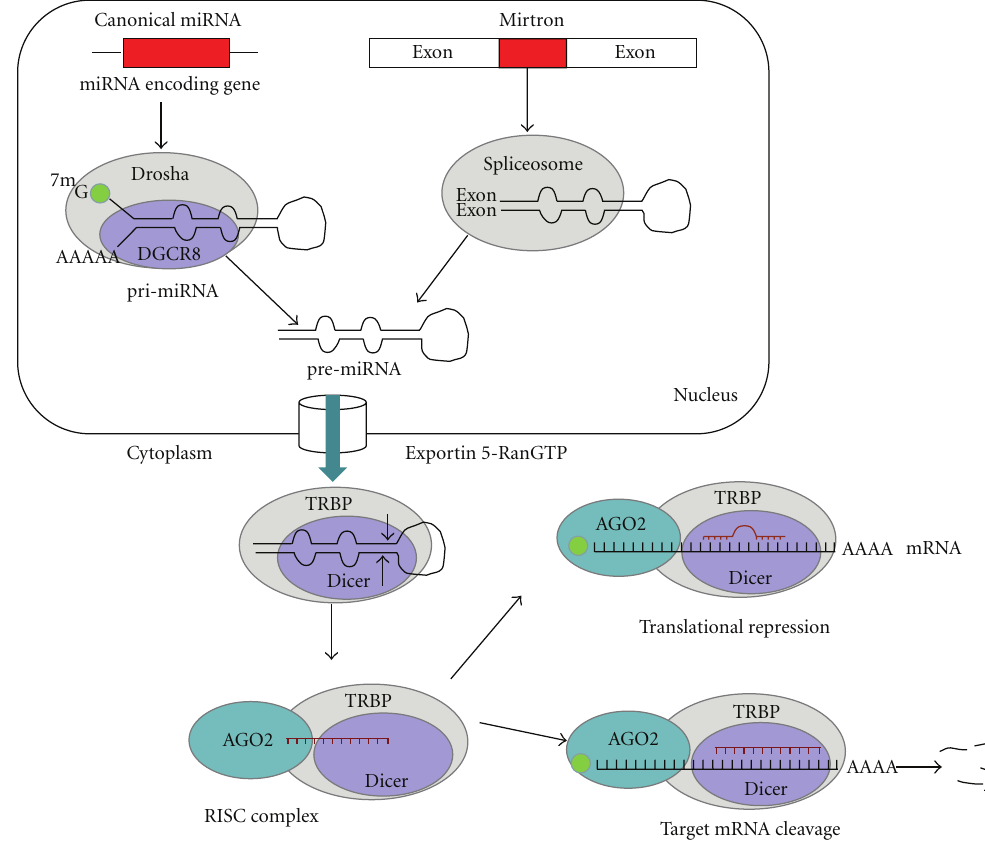
Figure 1: miRNA biogenesis. In the nucleus, canonicalmiRNAs are processed by the endoribonuclease, Drosha, in partnership with DGCR8. In contrast, mirtrons are processed by the spliceosome. The pre-miRNA is then exported from the nucleus into the cytoplasm by Exportin-5, and it is processed into a mature miRNA by Dicer. After RISC incorporation, mature miRNAs inhibit translation or promote degradation of their target mRNA transcripts depending on the degree of complementarity between the 3 (cid:2) -UTR of the target mRNA and the seed region of the